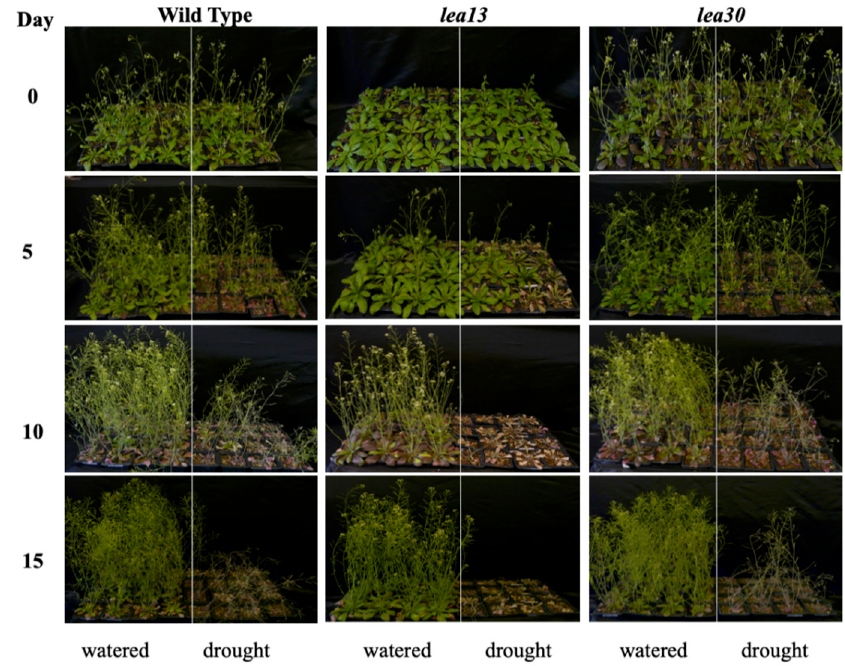
Figure 2. Tolerance to water deficit stress. Six-week-old plants were subjected to water stress, sampled at days 0, 5, 10, and 15 after cessation of irrigation, and analyzed for overall plant phenotype. The lea13 and lea30 lines showed greater susceptibility to water stress than the wild-type, which was more evident on day 10. Although all plants were planted and grown in the same space and conditions, the lea13 and lea30 lines showed a delay in development regardless of whether they received irrigation or drought, more pronounced in the lea13 line. Ten plants for each line were used as the experimental unit. Photographs were taken just in the drought stress (Left control plants were well-watered, and on the Right side are plants subjected to drought stress).